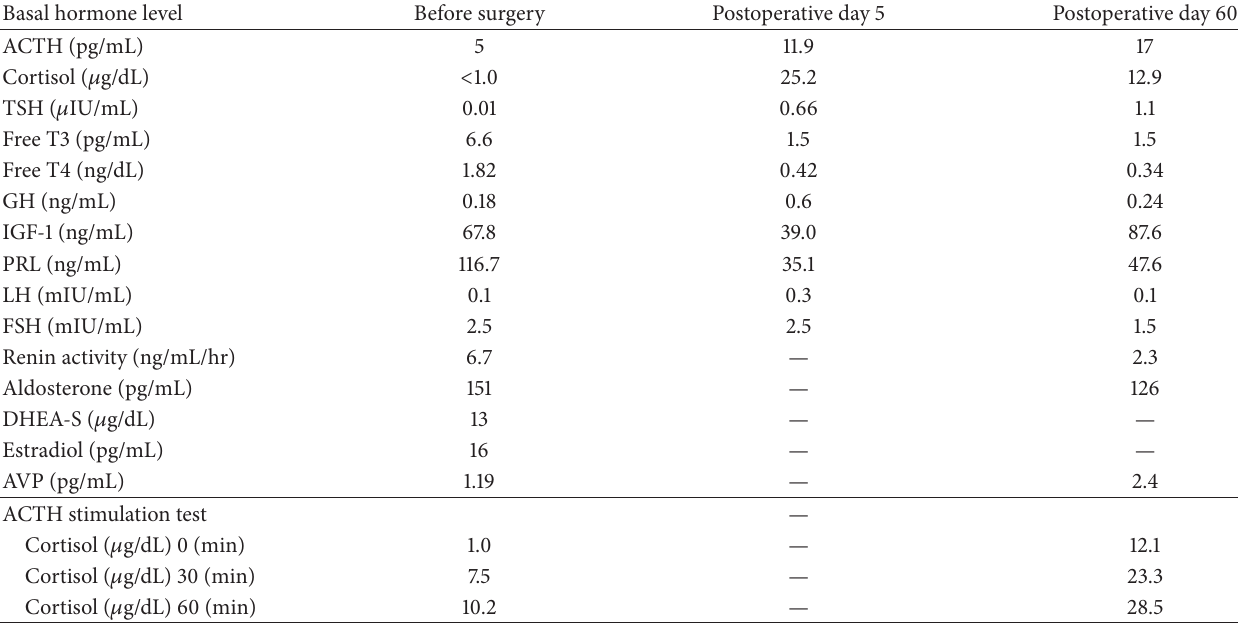
Table 1: Preoperative and postoperative basal endocrine